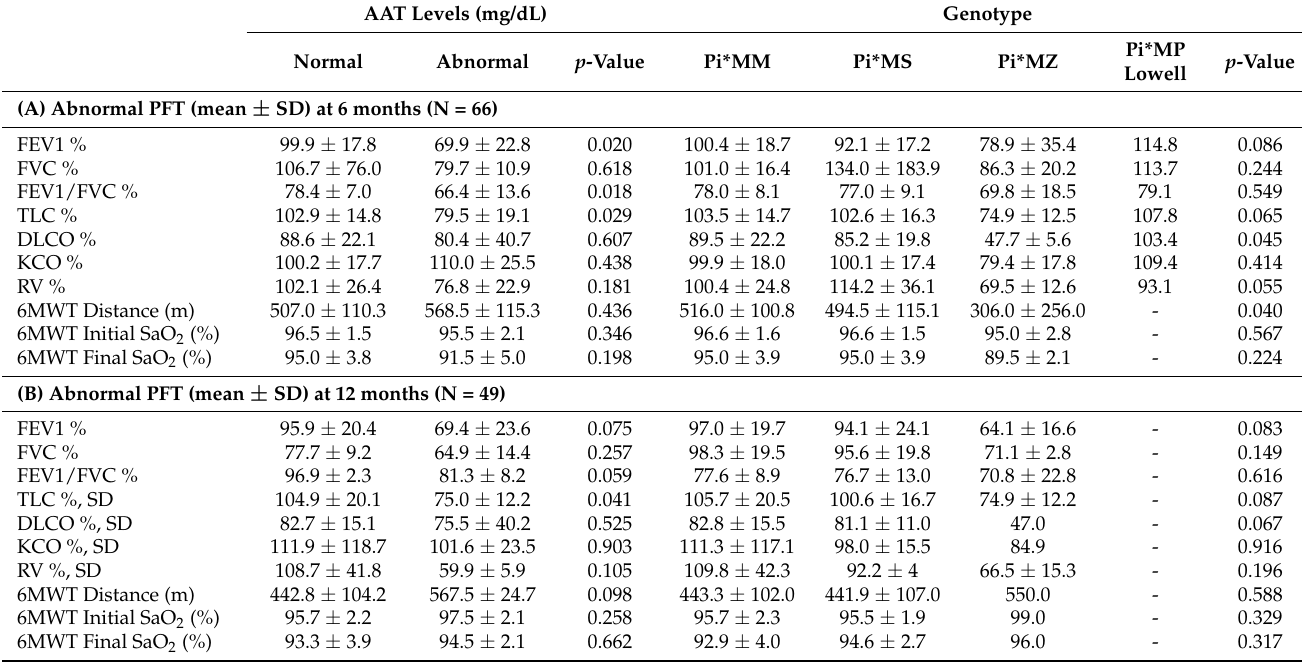
Table 4. Association between alpha-1 antitrypsin (AAT) levels results and allelic genotype with pulmonary function test parameters at 6 and 12 month follow-up